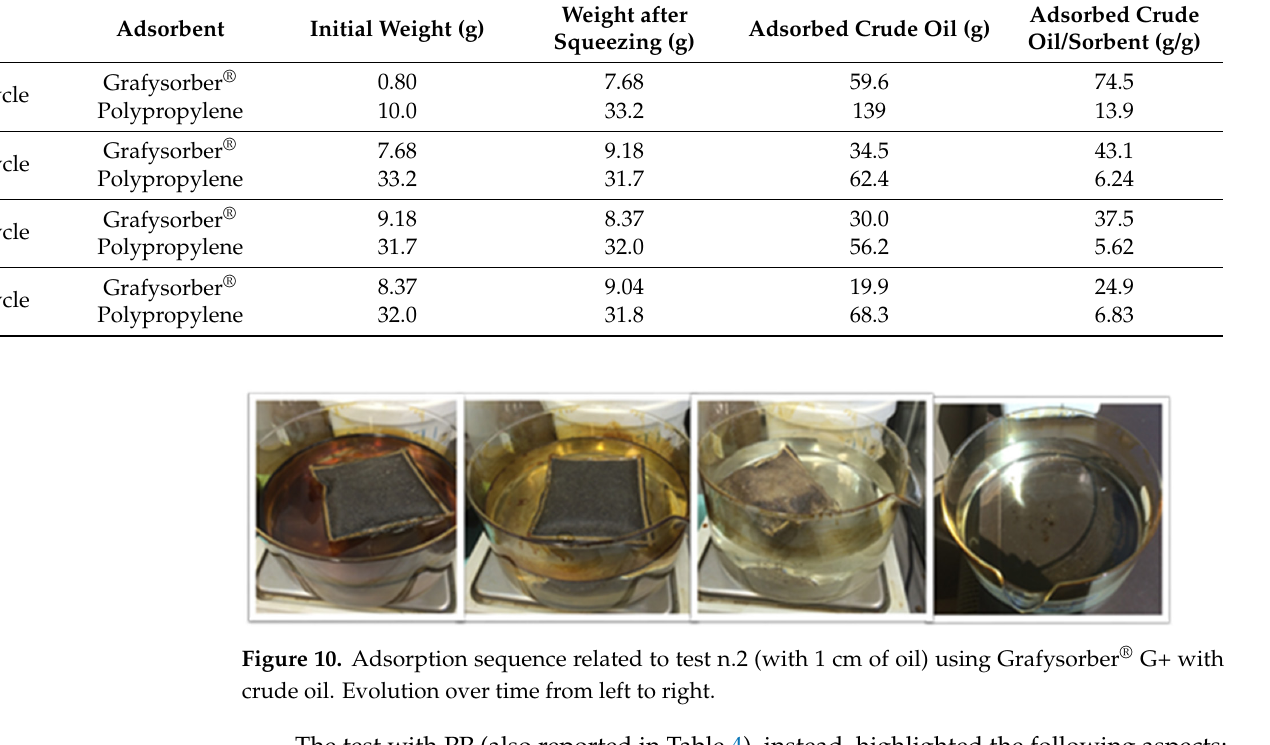
Table 4. Crude oil adsorption tests with Grafysorber ® G+ and Polypropylene.